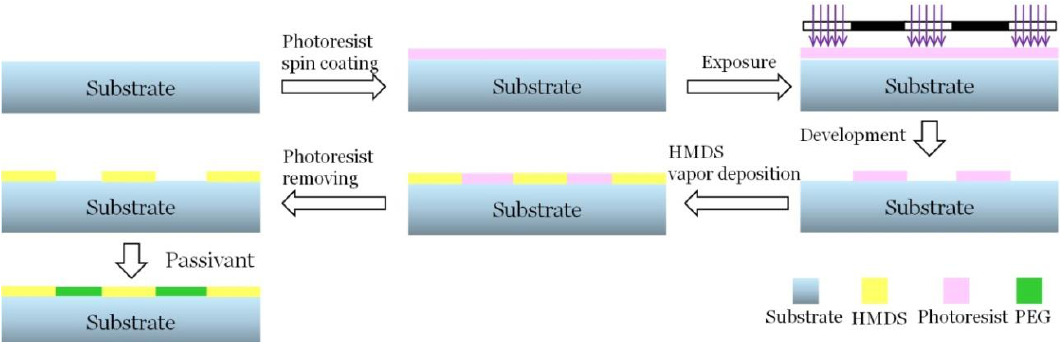
Figure 1. Surfacemodification process of the substrate. The photoresist mask was formed by direct lithography and the chemical vapor deposition (CVD) process was employed, followed by photoresist release and passivation treatment. HMDS: hexamethyldisilazane; PEG: polyethylene glycol.